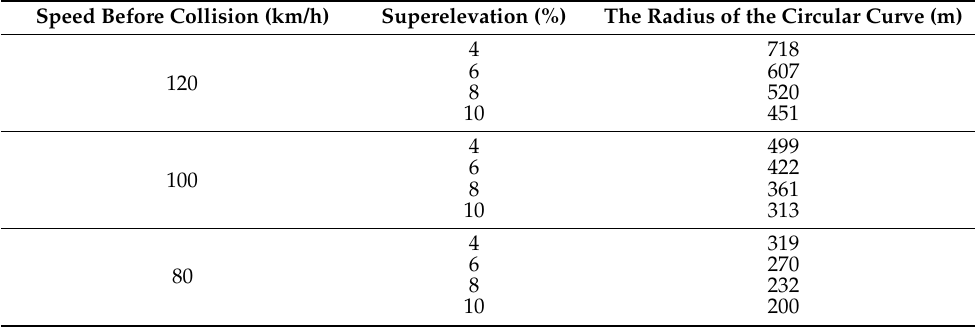
Table 3. Optimization scheme of the minimum radius of circular curves. Speed Before Collision